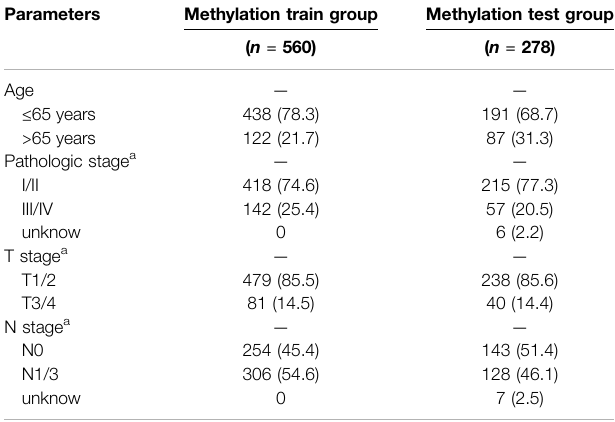
TABLE 1 | General clinical characteristics of 560 BC